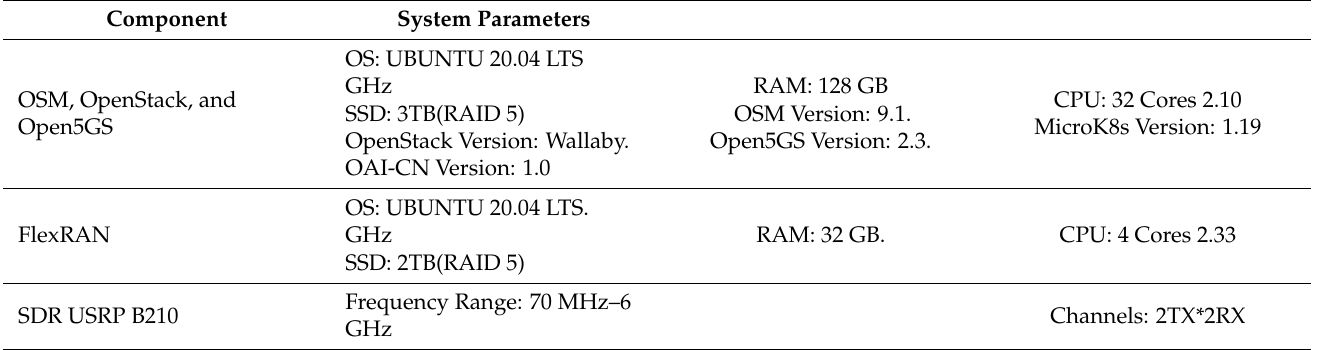
Table 1. Testbed resource